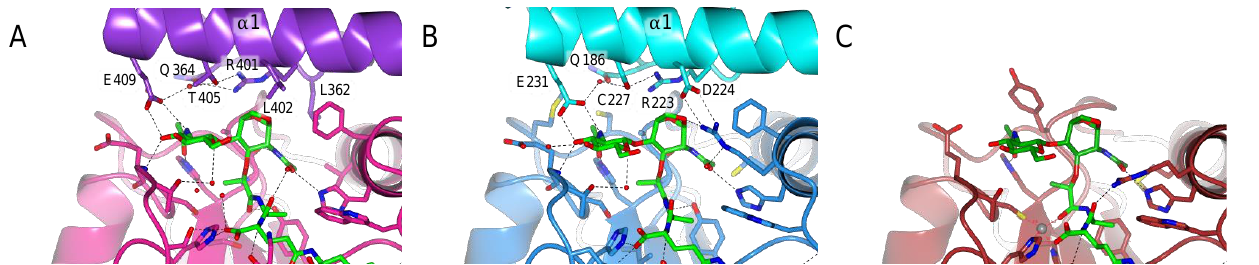
Figure 4. Interaction between carbohydrate moiety of the TCT represented in green and Drosophila PGRPs. Only the residues from the helix α 1 are responsible for the dimerization and interactions with TCT are annotated. ( A ) Dimer interface of PGRP-LCx in pink and PGRP-LCa in violet (PDB 2F2L) [23]. ( B ) Dimer interface of PGRP-LE, the main interacting chain is in blue and the chain at the dimer interface is in cyan (PDB 2CB3) [24]. ( C ) Model for the interaction of the PGRP-LB PA/PC with the sugar moiety of the TCT. The missing sugar moiety has been modelled using Maestro and Prime (Schrödinger, LLC, New York, NY, 2020) and colored in darker green. Hydrogen bonds are represented by black dotted lines; red dotted lines show the Zn 2+ (grey ball) chelation. The structure figures were made using CCP4mg